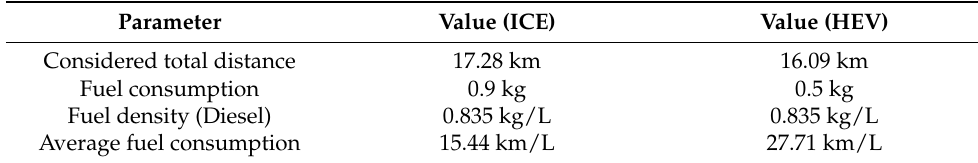
Table 4. Average fuel consumption comparison for both configurations.